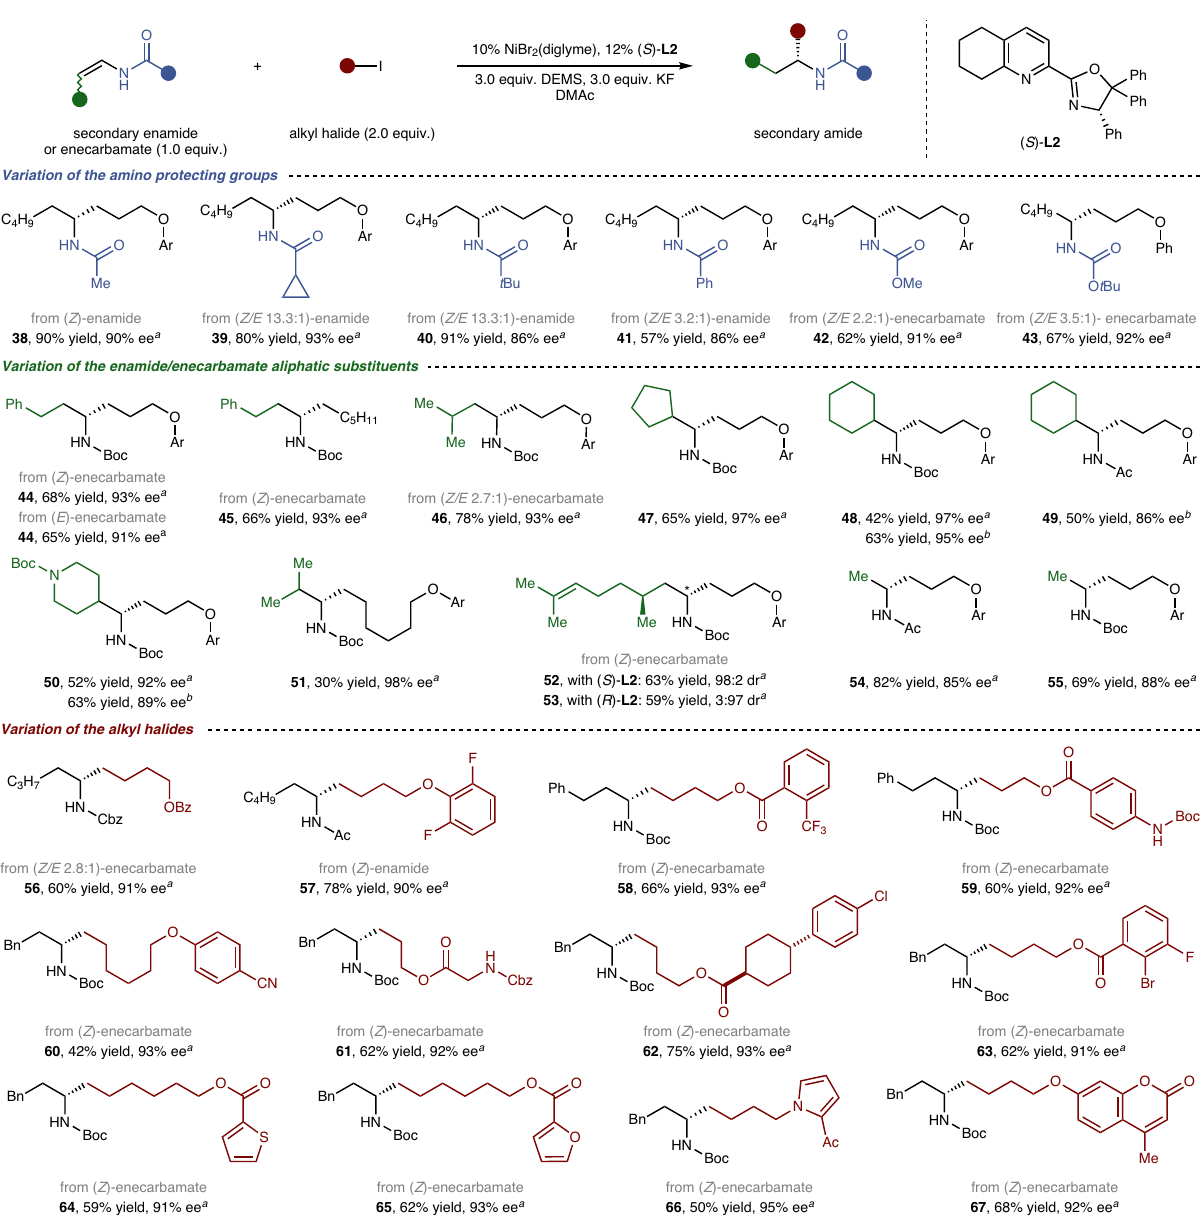
Fig. 3 Asymmetric reductive hydroalkylation of secondary enamides or enecarbamates. a DMAc (0.2 M), − 27 °C, 40 h, isolated yield, 0.20 mmol scale. b DMAc (0.2 M), 0 °C, 40 h, isolated yield, 0.20 mmol scale. c Diastereocenters marked with an asterisk symbol. Ar = 2-naphthyl, Ac = acetyl, Bz =